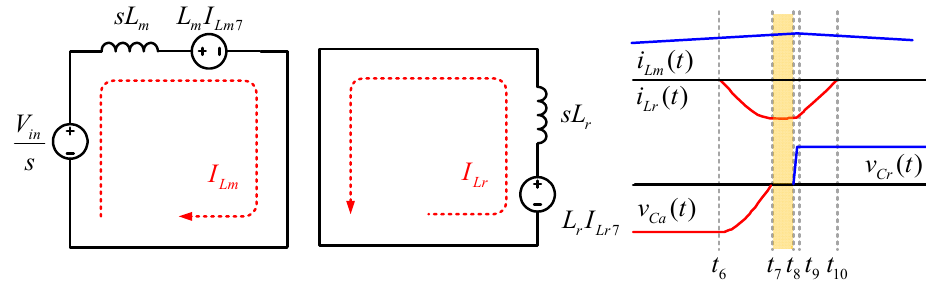
Figure 11. The equivalent circuit of Mode 8 and key waveform.